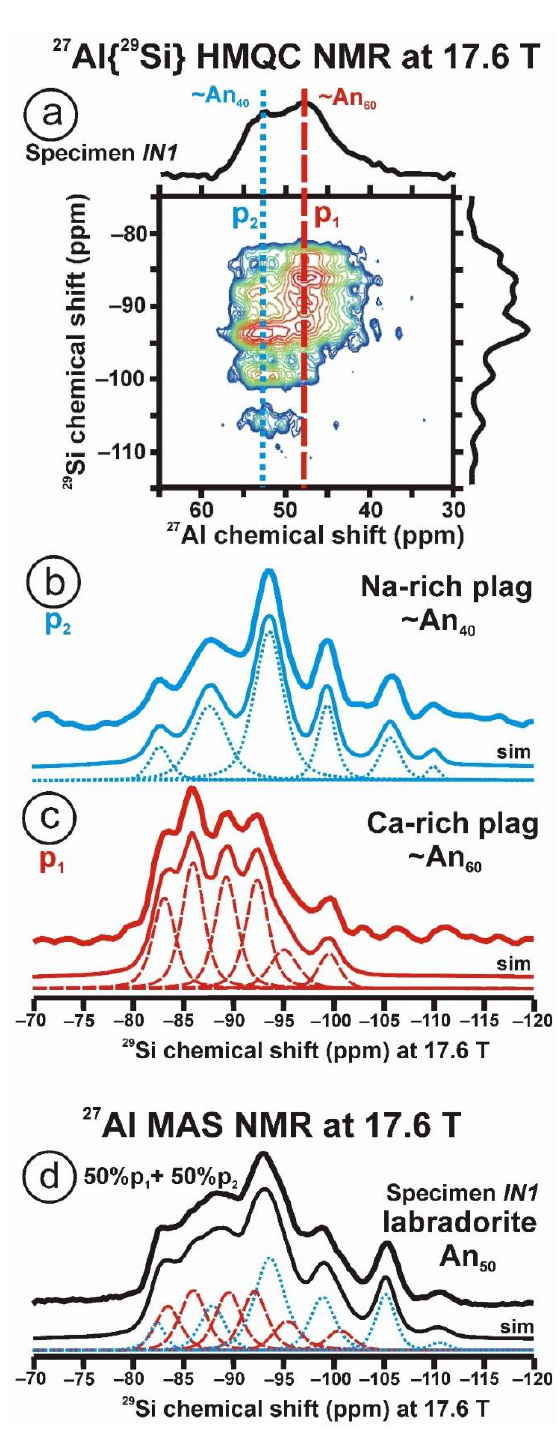
Figure 17. ( a ) The 27 Al{ 29 Si} HMQC NMR spectrum of specimen IN1 of labradorite An 50 , in which two compositions are recorded along the 27 Al axis at 48 ppm for plagioclase p 1 (blue) and at 53 ppm for plagioclase p 2 (red). ( b ) The 29 Si spectrum for a section at 53 ppm to show the spectral component of the p 2 plagioclase ca. ~An 40 , with six Voigt curves at xG/(1 − x)L = 0.5. ( c ) The 29 Si spectrum for a section at 48 ppm shows the spectral component of the p 1 plagioclase ca. ~An50, with six Voigt curves at xG/(1 − x)L = 0.5. ( d ) Deconvolution of the 29 Si MAS NMR spectrum by using 50% p 1 + 50% p 2 (see Table 7), with slight variations in the position and intensities of the signals with respect to the simulation of the sections in ( b , c ) from the 27 Al{ 29 Si} HMQC NMR spectrum. The spectrum was recorded at υ r = 14 kHz in a 4 mm rotor, using a {9.0}13 .5 μs excitation pulse, and a recycle delay of 1.0 s. For additional information about this type of experiment, see [52].